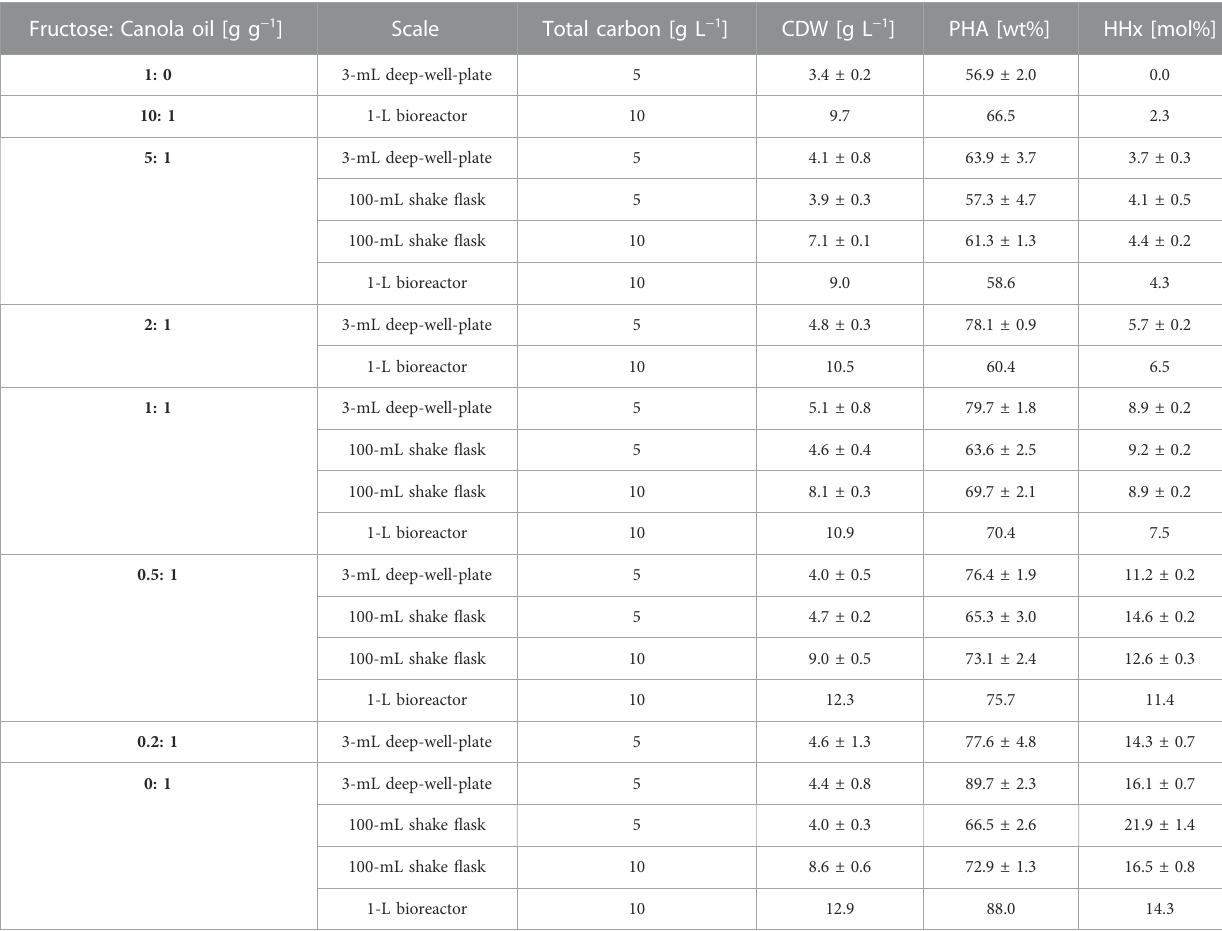
TABLE1Comparisonofbiomass,PHAcontentandcompositionobtainedamongallstudiedscaleswith R.eutropha Re2058/pCB113 usingmixturesoffructoseand canola oil as carbon source and urea as nitrogen source with an applied C/N ratio of 22 g g-1. For deep-well-plate cultivations, CDW measurements represent meansfromtriplicatecultivationsandPHAandHHxmeasurementsrepresentmeansfromduplicatemeasurementsofpulledsamples.Forshake fl askcultivations, measurements represent means of triplicate cultivations. ± are indicating standard